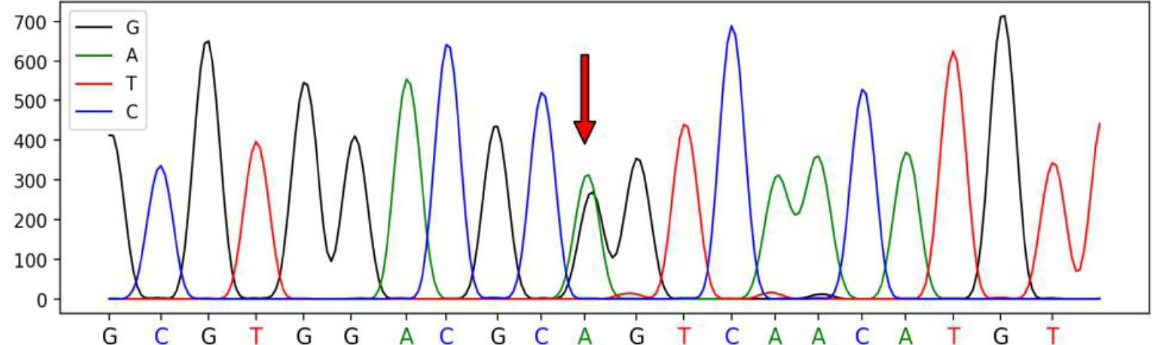
Figure 1. The sequencing peak map of the SSTR1 and the mutated SNP1 site of Hulun Buir sheep. The sites marked by the red arrow was the SNP1 mutation, which was found and identified in exon 2 of SSTR1 , A345G (rs415509729). The sequences were analyzed using DNAMAN software.